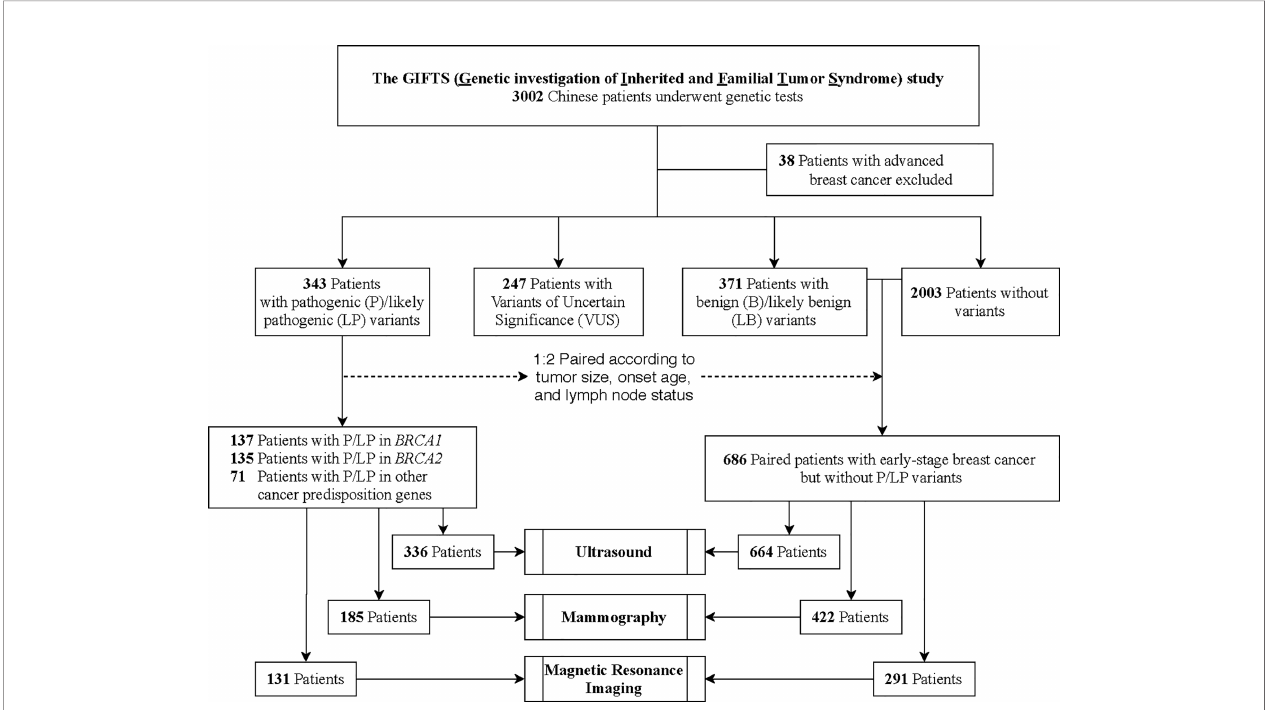
FIGURE 1 | Patient Enrollment and Study Design. In this study, 3002 breast cancer patients were enrolled from three hospitals in China. Thirty-eight patients with advanced breast cancer were excluded. In total, 343 patients were found to harbor germline pathogenic variants (GPVs) in cancer predisposition genes (CPGs). To compare performances of ultrasound, mammograms, Magnetic Resonance Imaging (MRI), and combining strategies between different mutation status, 686 non- carriers were selected as 1:2 paired with the CPG mutation-carriers according to the onset age, tumor size, and lymph node